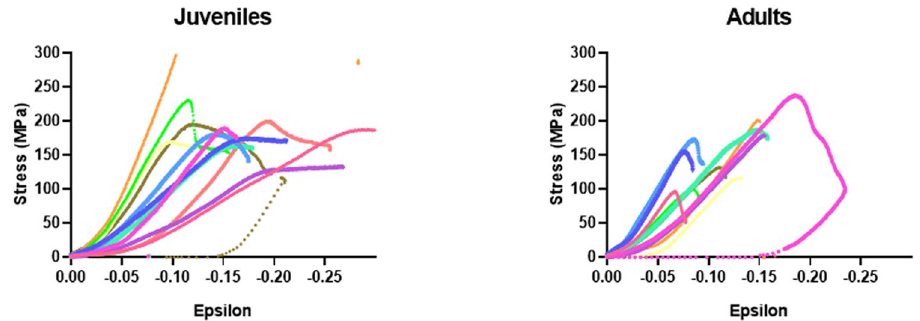
Figure 3. Mechanical raw data from juveniles (left) and adults (right) samples.